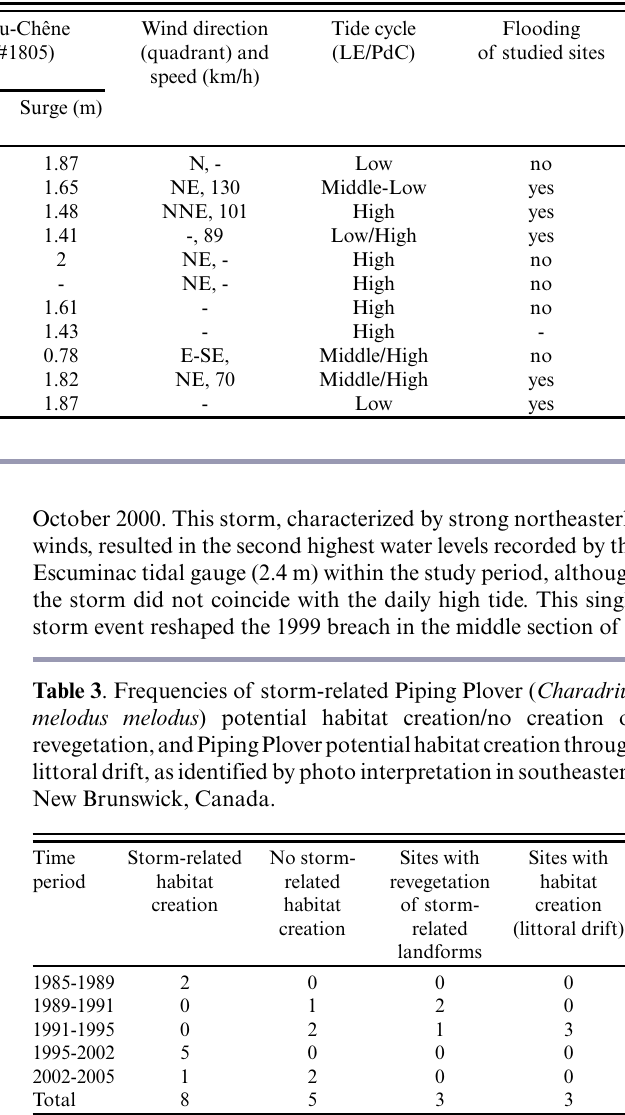
Pointe-du-Chêne Wind direction Tide cycle Flooding Escuminac (TGS #1805) (quadrant) and (LE/PdC) of studied sites speed (km/h)